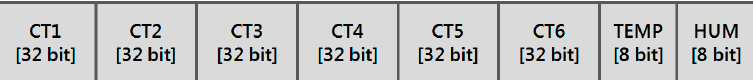
Figure 5. Our LoRa data frame.